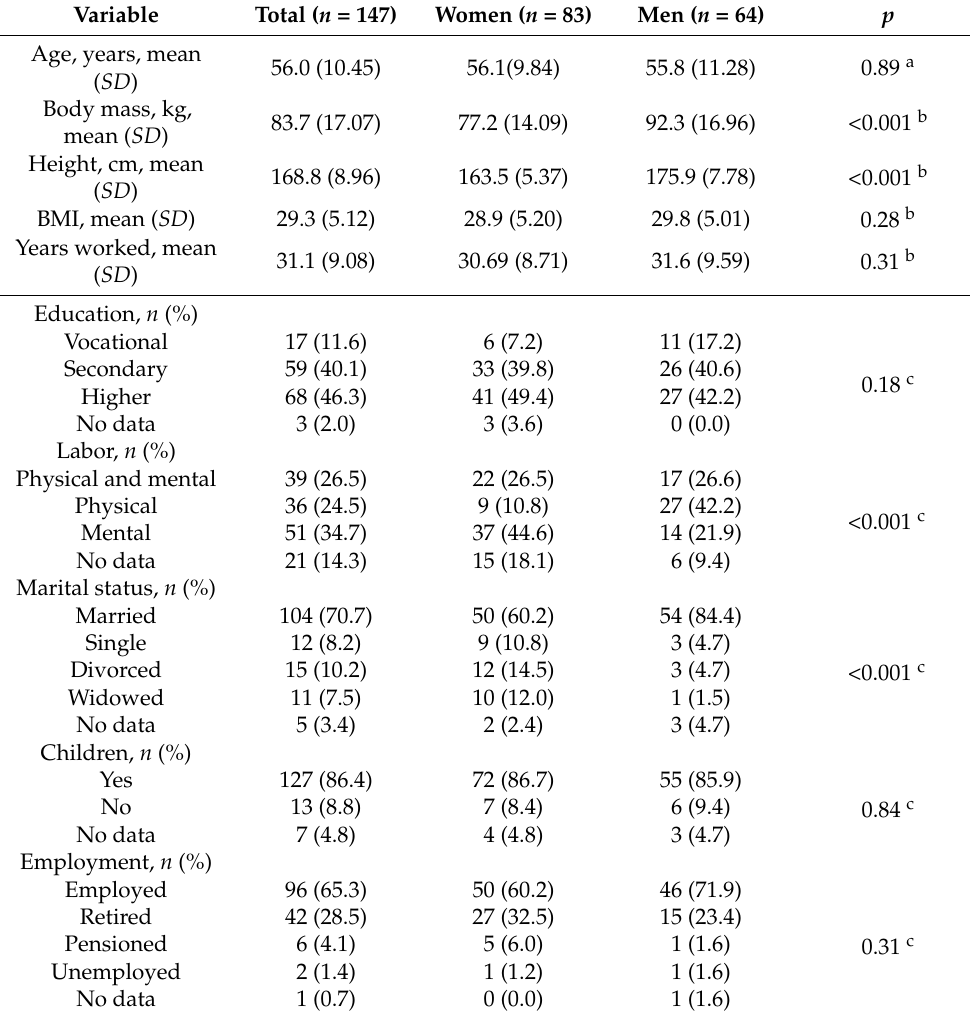
Table 1. Table 1. Sociodemographic